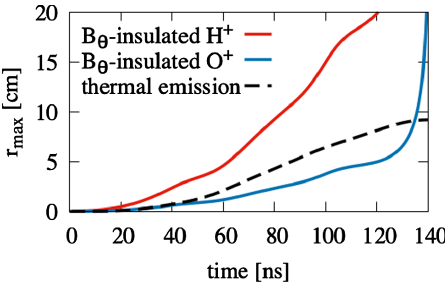
FIG. 6. The maximum radius at which ions are magnetically insulated as a function of time (Eq. (17) for a 7-mm gap. The water constituents H þ and O þ are plotted in red and blue, respectively. The maximum radius for thermal emission from Eq. (12) for Δ T ¼ 400 K (in black) shows thermally emitted H þ are